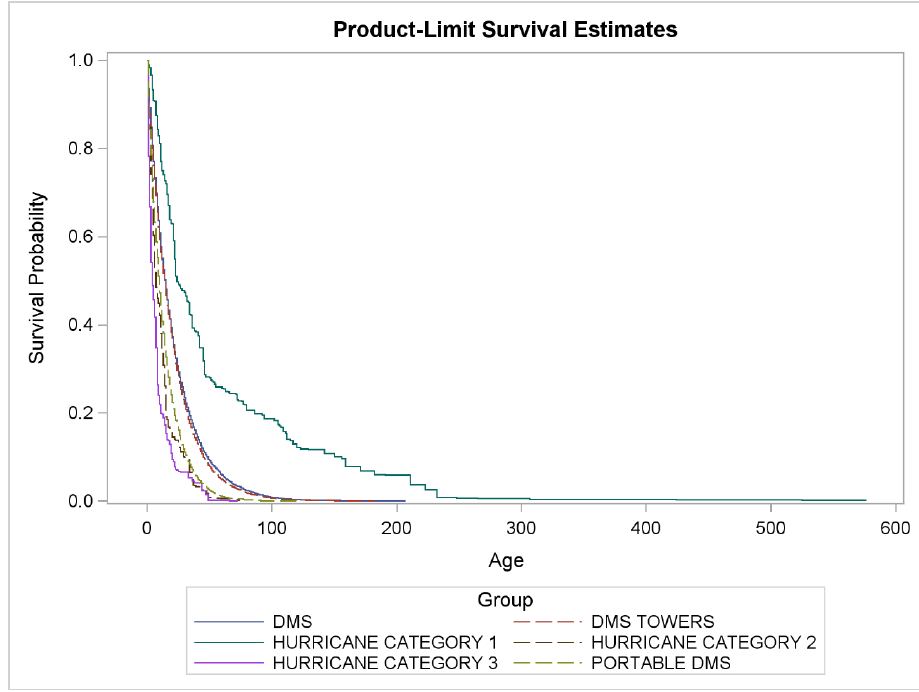
Figure 6. Product limit survival estimates for dynamic message sign (DMS) components compared with hurricane failure intensities.